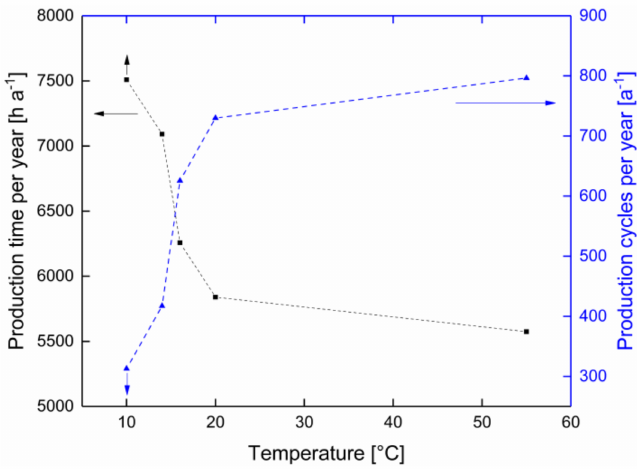
Figure 5. Production time ( (cid:4) ) and the number of production cycles ( (cid:78) ) as functions of the product temperature ( ϑ = 10–20 ◦ C and 55 ◦ C). Dotted lines are guides for the